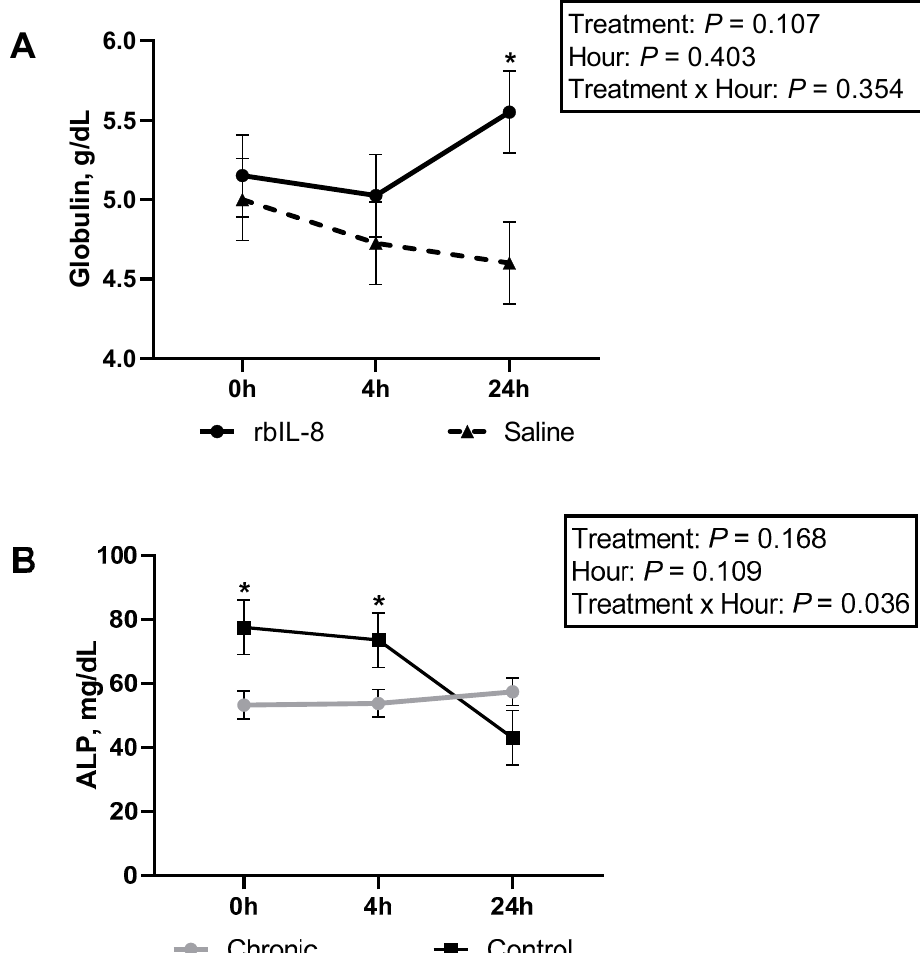
Figure 9. Circulatory concentrations of globulin ( A ) and ALP ( B ). In ( A ), the comparison between the infused groups (rbIL-8 vs. saline) is shown, and in ( B ), the comparison between the chronic (rbIL-8 and saline) vs. control, in hours relative to treatment. Significant time point differences ( p < 0.05) between groups are represented with an asterisk